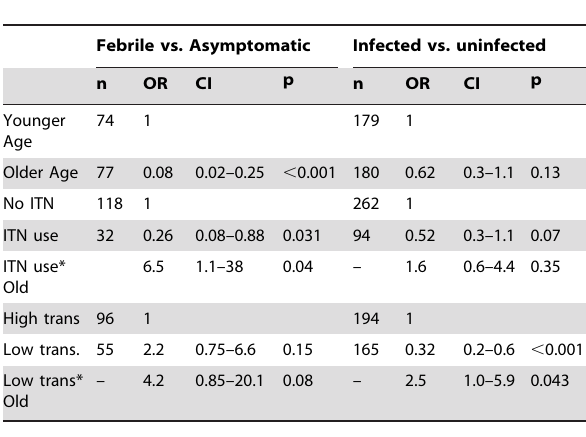
Table 3. Logistic models to examine the effect of ITN use and transmission intensity on the category of malaria infection, and their interactions with